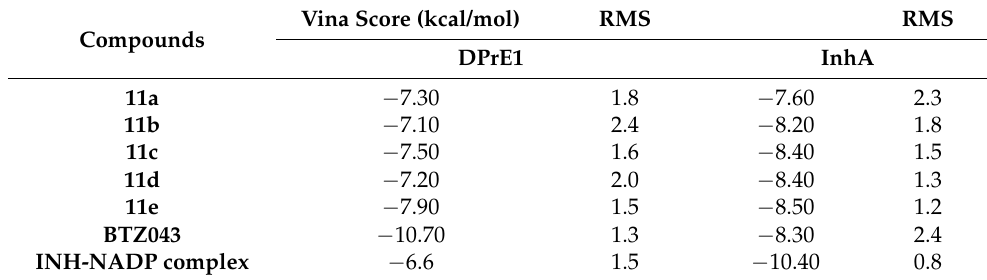
Table 5. Vina scores were obtained for the designed compounds and the reported target inhibitors. Compounds